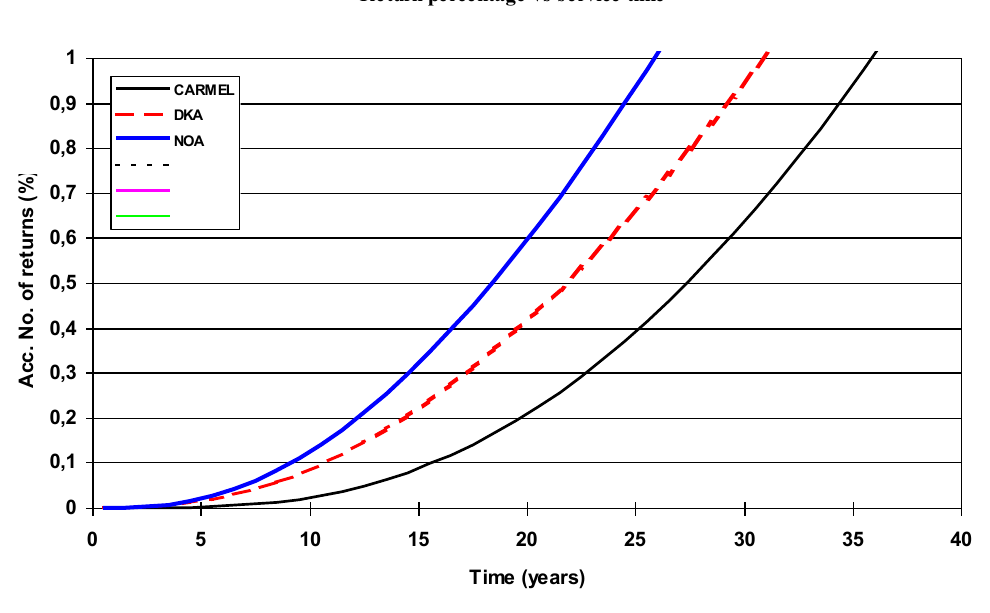
Figure 11. Optimum fit functions to correlate car population with melanoma incidence in Norway, Denmark and Sweden. The result indicates no similarity at all between cars and melanoma in the different countries. Return percentage vs service